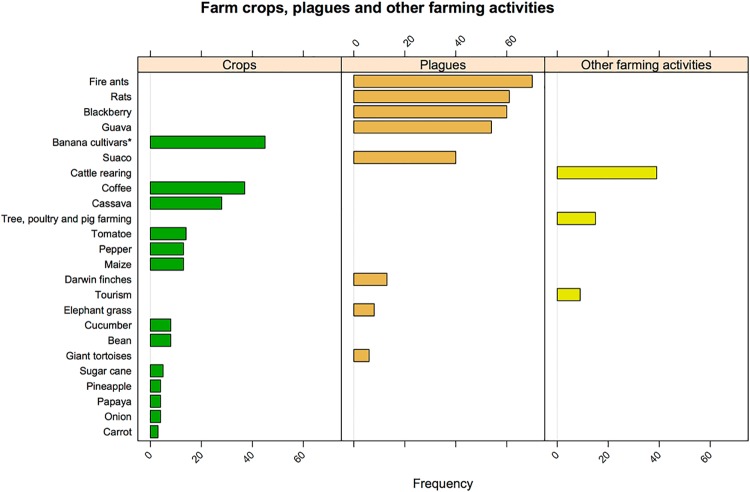
Main characteristics of the sampled farms.Animal plagues are fire ants (Solenopsis geminata and Wasmannia auropunctata) and rats (Rattus rattus and Rattus norvegicus); whereas plant plagues are blackberry (Rubus spp.), guayava (Psidium guajava), elephant grass (Pennisetum purpureum) and sauco (Cestrum auriculatum). (*) Indicates a variety of grown banana cultivars (e.g. guinean, green bananas, plantain). Frequency refers to the absolute number of farmers reporting the respective characteritics over the total sample (N = 102).